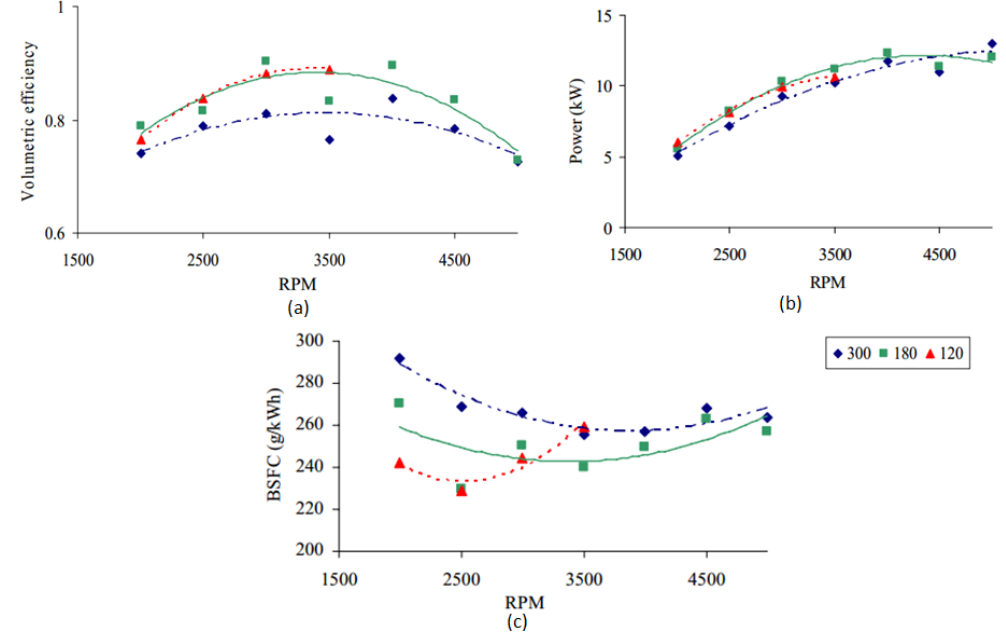
Figure 15. Volumetric efficiency ( a ), brake power ( b ), and brake-specific fuel consumption (BSFC) ( c ) of different injection timings at various engine speeds [162].